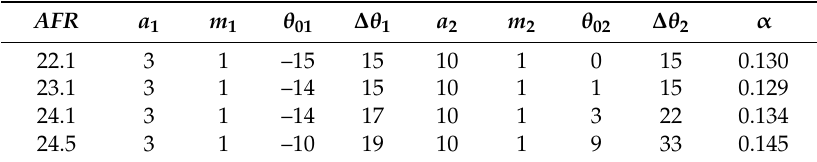
Table 5. Parameters of the double-Wiebe